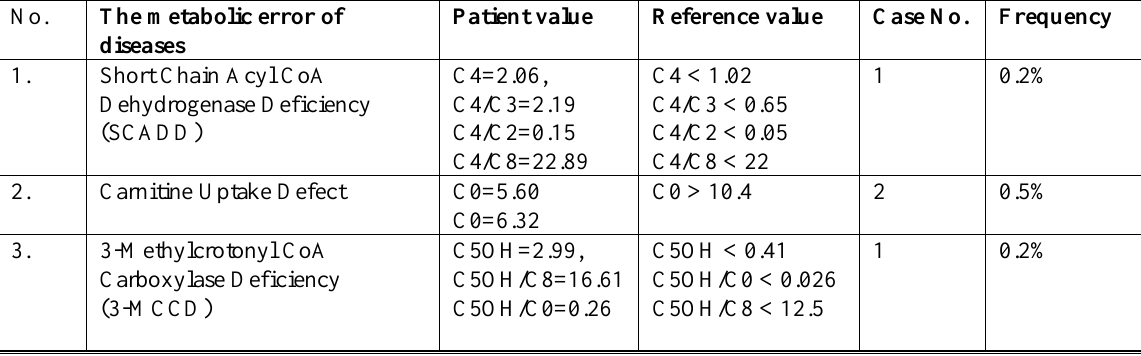
Table 2 . Mitochondrial inborn error of metabolism cases